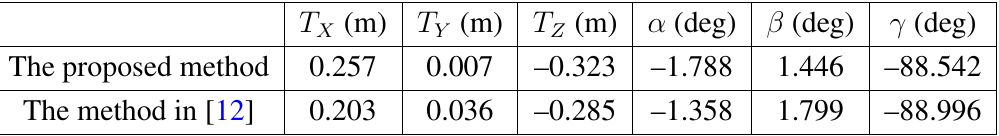
Table 1. Calibration results of a real 3D LIDAR-camera